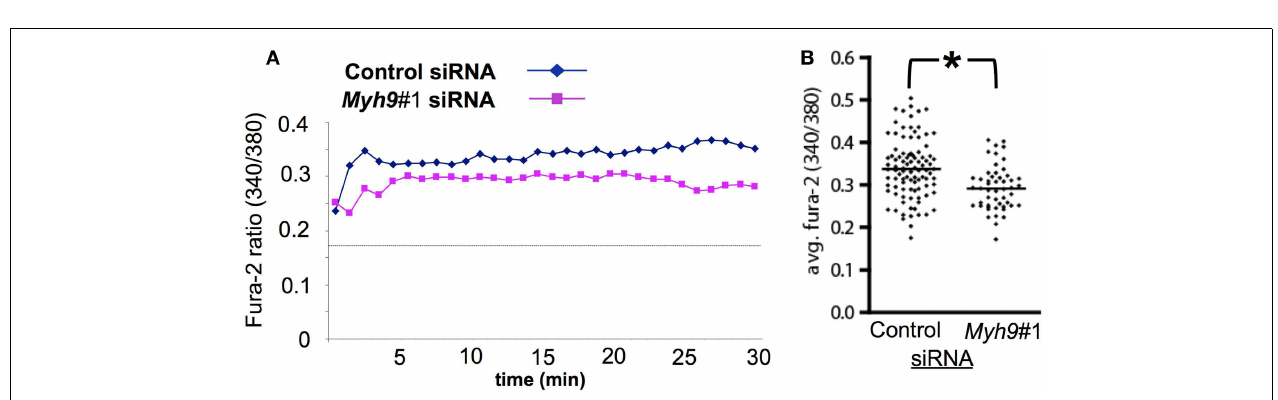
concentration, at the bottom. Each horizontal line represents one pseudo-colored radial average for an individual cell. Myh9 #1 siRNA-treated cells showed reduced SFK phosphorylation. (B) . Scatter plot showing the mean p Src intensity for Myh9 #1 and control siRNA-treated cells.The integrated p Src values for the contact areas were significantly different * p < 0.0001.The experiment was repeated twice with similar results.